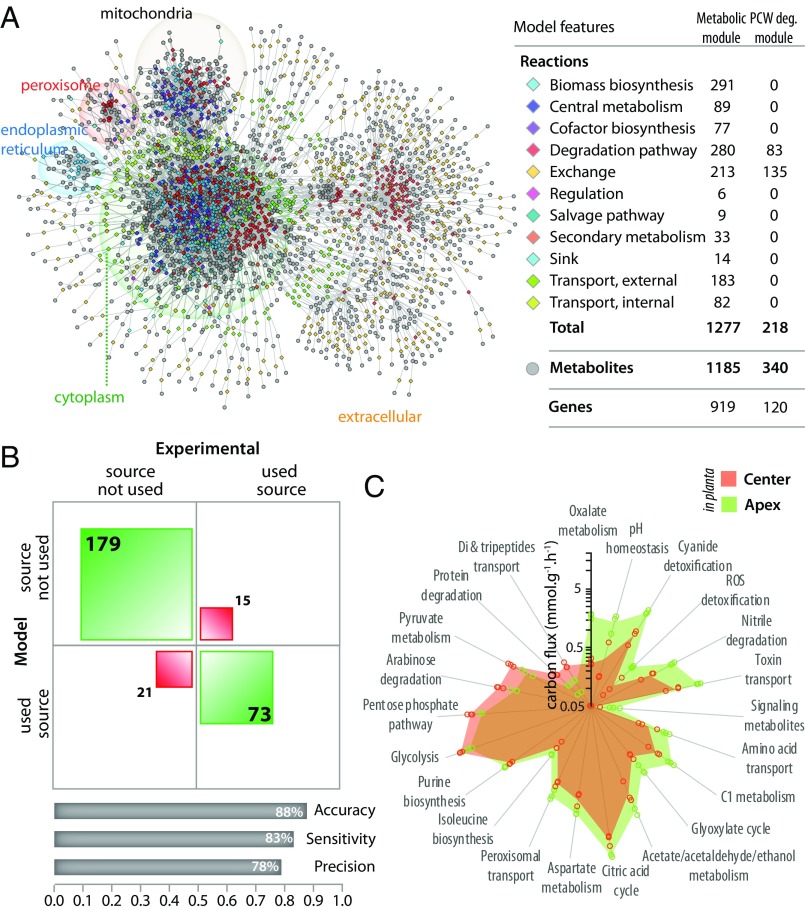
Division of labor drives metabolic heterogeneity along S. sclerotiorum hyphae during host colonization. (A) Overview of reactions and metabolites included in S. sclerotiorum GEM highlighting the major cellular compartments and the extracellular compartment. The table describes features of S. sclerotiorum GEM with the number of reactions and genes associated with the metabolic module and plant cell wall (PCW) degradation modules. (B) Experimental evaluation of the performances of S. sclerotiorum GEM using Biolog phenotype microarrays. (B, Top) Contingency table of the modeled (rows) and experimentally determined (columns) metabolic capacities for S. sclerotiorum. The squares are sized according to the number or carbon sources; correct predictions are shown in green and incorrect predictions in red. (B, Bottom) Bars show performance statistics. (C) Radar plots showing metabolic pathways supporting significantly different carbon fluxes in center and apex cells during A. thaliana colonization. Shaded areas show mean fluxes calculated by FBA on three biologically independent global transcriptome sequencings, with values for individual replicates shown as dots.